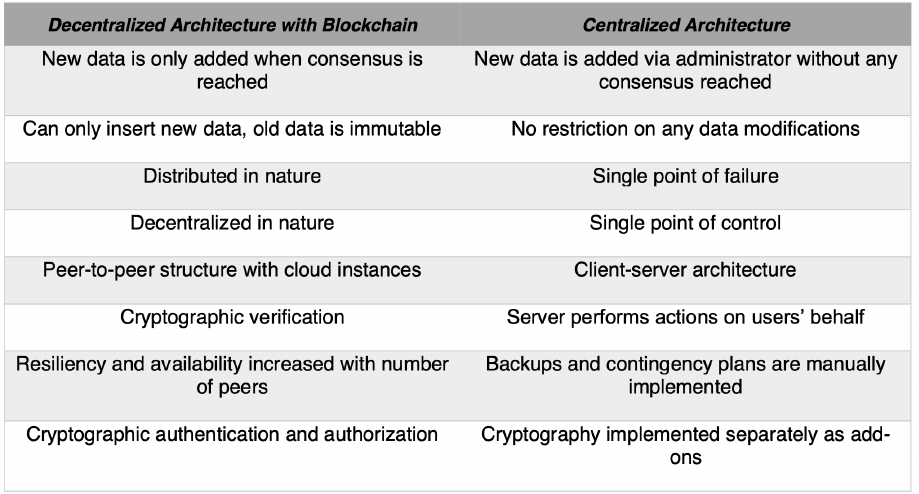
Figure 8. Comparison of decentralized and centralized